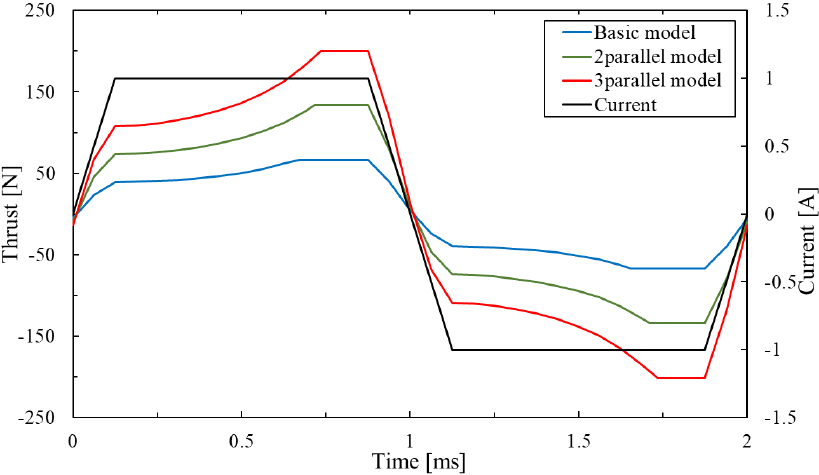
Figure 16. Thrust waveform of parallel type.